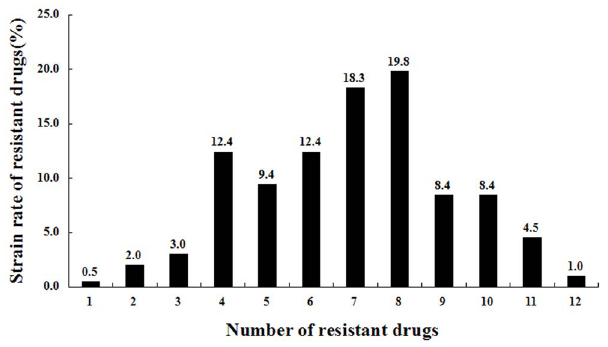
Figure 2. Resistance profiles of 202 Escherichiacoli isolates from four chicken farms to 12 antimicrobials. Note: one to twelve in the X axis represents resistance to one antimicrobial to twelve antimicro- bials. Y axis represents the rates of the isolates resistance to one antimicrobial to twelve antimicrobials.